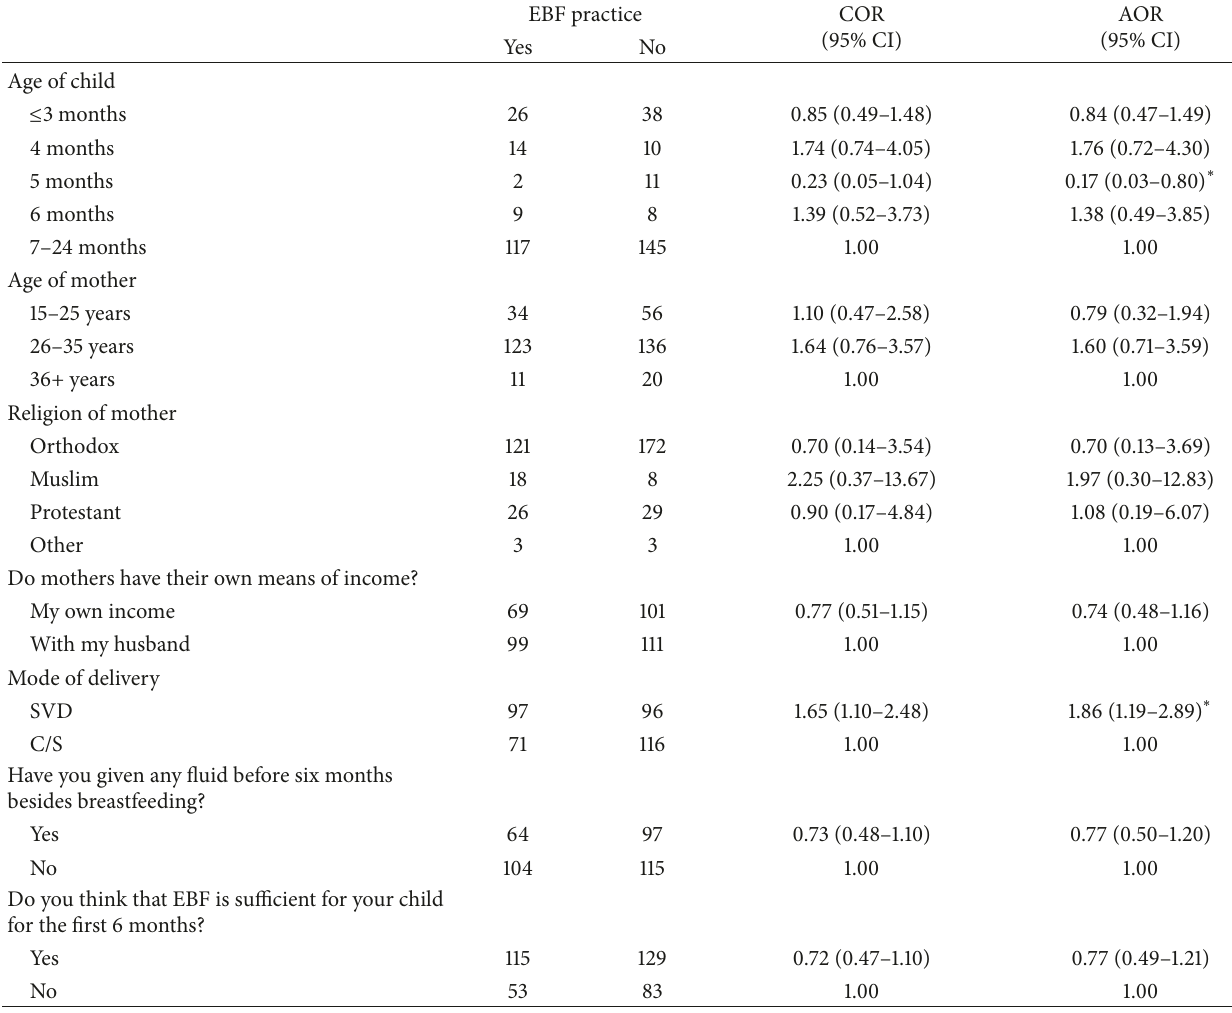
Table 4: Bivariate and multivariate logistic regression of factors affecting EBF of mothers attending private pediatric clinics, Addis